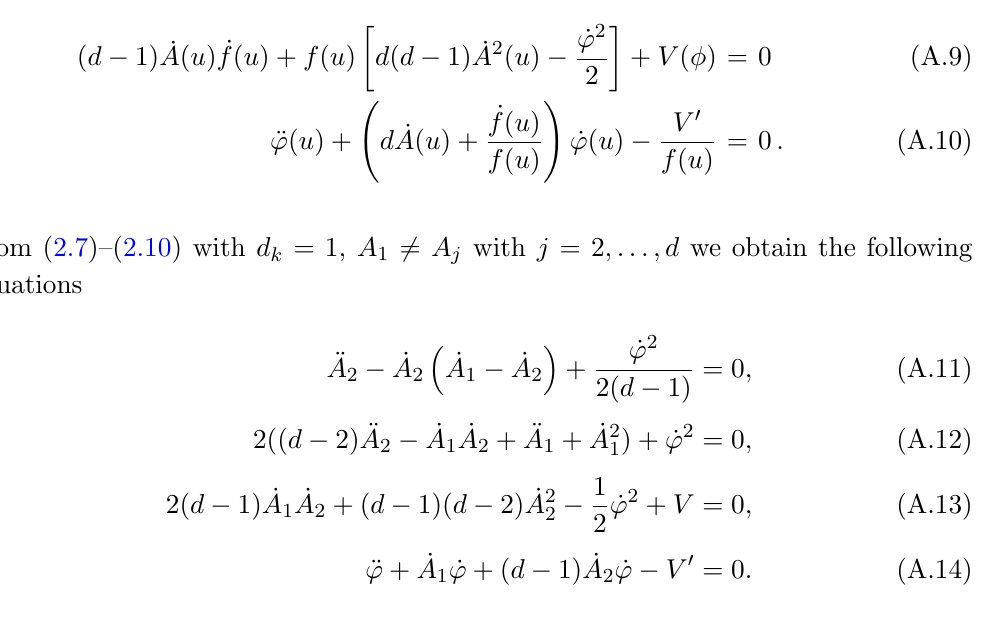
Figure 17 . Finite part (cid:22) F of the free energy (E.43) as a function of the ratio R 2 = R 1 , on the line of the ( R 1 ; R 2 ) (cid:0) plane where the radius of the sphere which shrinks to zero size in the IR is kept (cid:12)xed. We represent both the case where the sphere 1 shrinks (blue) and the case where the sphere 2 shrinks (orange). We normalize by the overall volume factor 32 (cid:25) 2 M 3 two curves (cid:12)rst cross at R 1 = R 2 corresponds to a bifurcation, where the sphere that shrinks is exchanged and the asymmetric vev changes